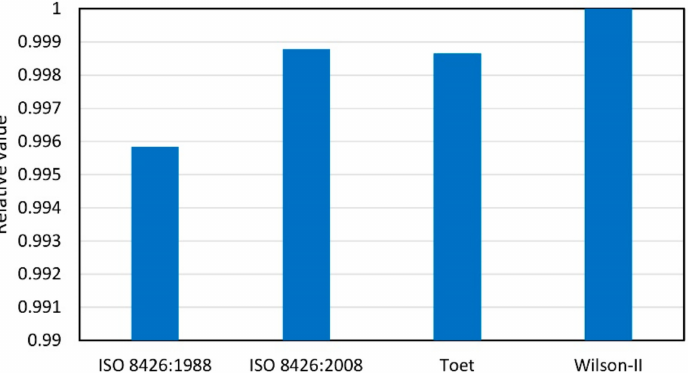
Figure 2. Derived capacities determined with different methods. Values relative to the result given by the Wilson-II